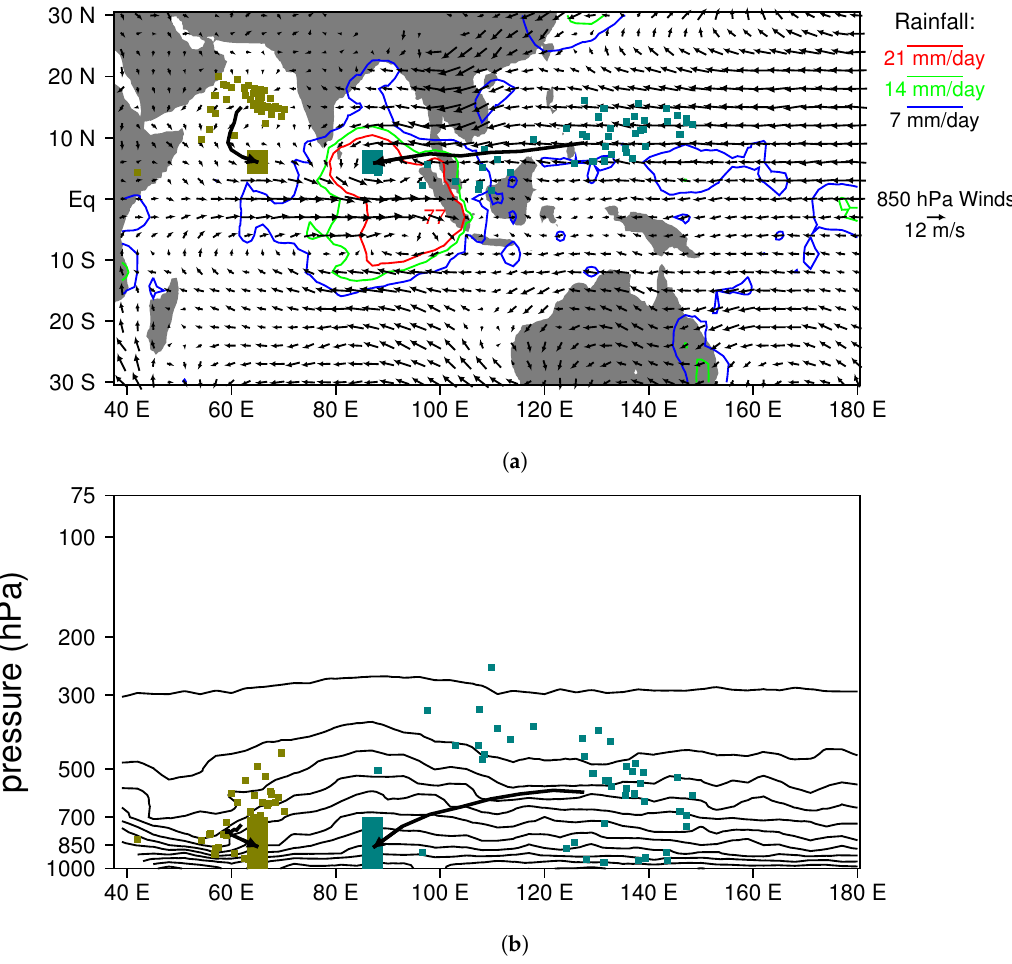
Figure 11. Back trajectory analysis of moist (aqua) and dry (gold) regions in the April 1998 MJO simulated with the higher-resolution version of the LAM. ( a ) 9 April rainfall and 850-hPa flow. All parcels centered within the large aqua and gold boxes on 9 April are tracked backwards in time seven days, and their positions on 2 April are marked with small colored boxes. The mean parcel path over the seven days for each region is shown with a thick black line. Average specific humidity over 3–9 N is contoured in panel ( b ) with a 2 g/kg contour interval. Note that in the moist region with heavy rainfall (large aqua box) most parcels have come from mid-levels in the atmosphere over the equatorial western Pacific, whereas in the dry region with light rain (large gold box), parcels have come from the lower troposphere over the northern Arabian Sea.